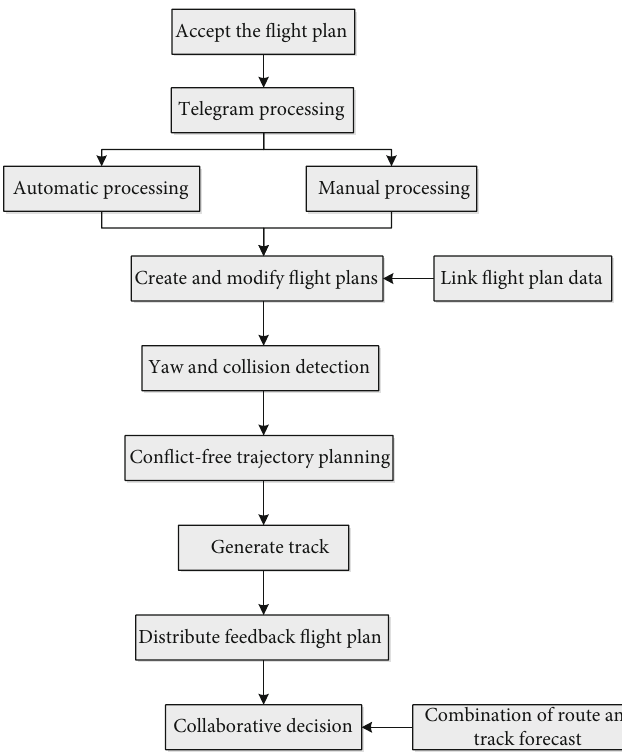
Figure 1: Flow chart of fl ight path planning for fl ight plan centralized processing